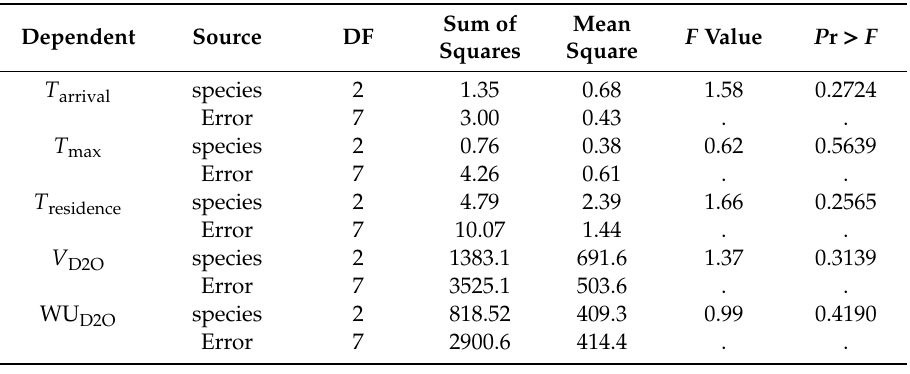
Table A1. Testing result of the homogeneity of variance among the unbalanced data. The tested water transport characteristics based on deuterium tracing on four culms for B. vulgaris and three culms for G. apus and D. asper : times when deuterium arrived in the canopy ( T arrival , days), reached the maximum concentration ( T max , days) and amount of time it remained in the bamboos ( T residence , days). Derived daily water use (WU D2O , kg day − 1 ) and daily sap velocity ( V D2O , m day − 1 ). ‘ P > 0.05 ( P r > F )’ indicate equal variance among species.